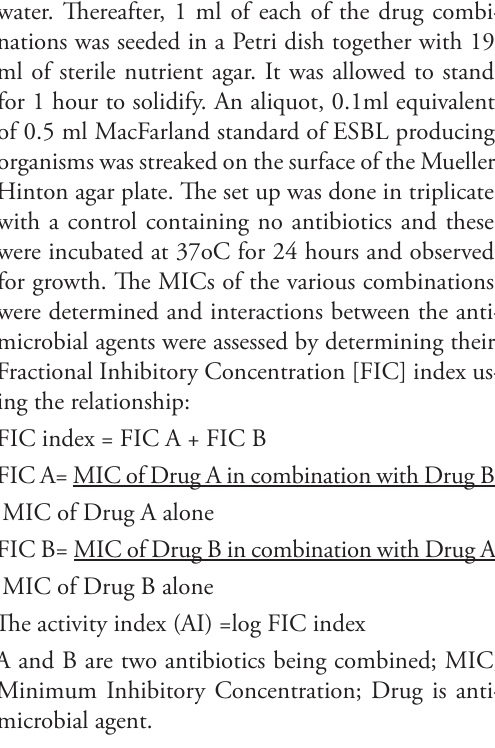
GEN, Gentamicin; AMC, Amoxycillin/Clavulanic acid; CRO, Ceftriaxone; CIP=Cipro fl oxacin; PEF, Pe fl oxacin; CXM, Cefuroxime; Cm, Community isolates; Hp, Hospital